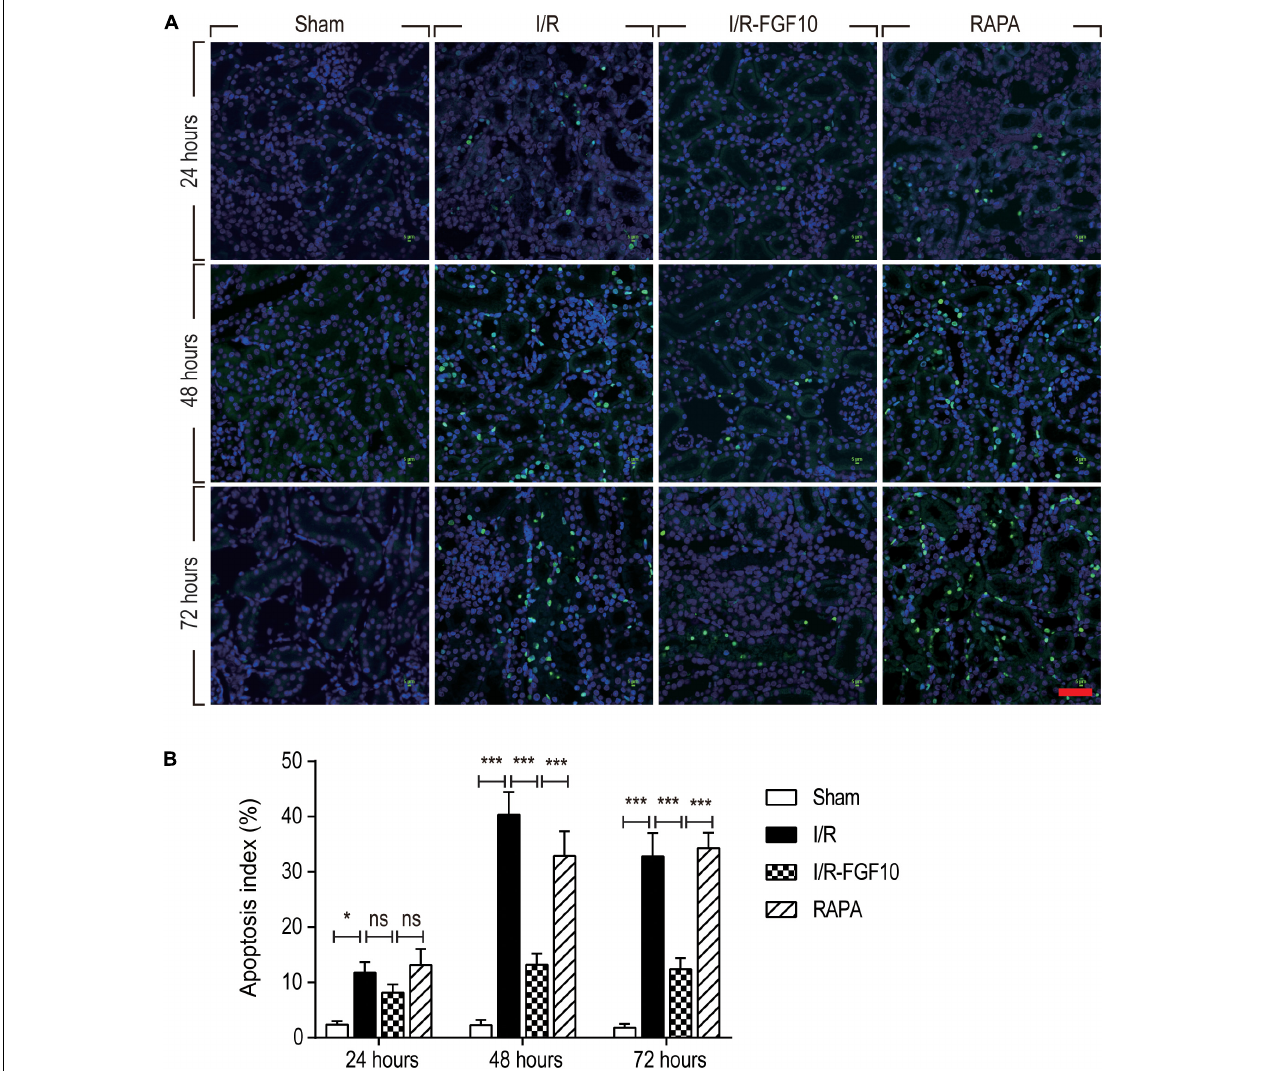
FIGURE 2 | FGF10 protects against I/R induced apoptosis in RTCs. (A) Representative sections of nuclear DNA fragmentation staining were performed using TUNEL in different groups at 24, 48, and 72 h, respectively, after reperfusion. Scale bars = 50 µ M. (B) Quantitative analysis of the number of TUNEL-positive RTCs. Data are presented as the mean ± SD ( n = 5). ∗ P < 0.05, ∗∗∗ P < 0.001. The percentage of positive cells was analyzed with 5 individual magnification × 400 fields per